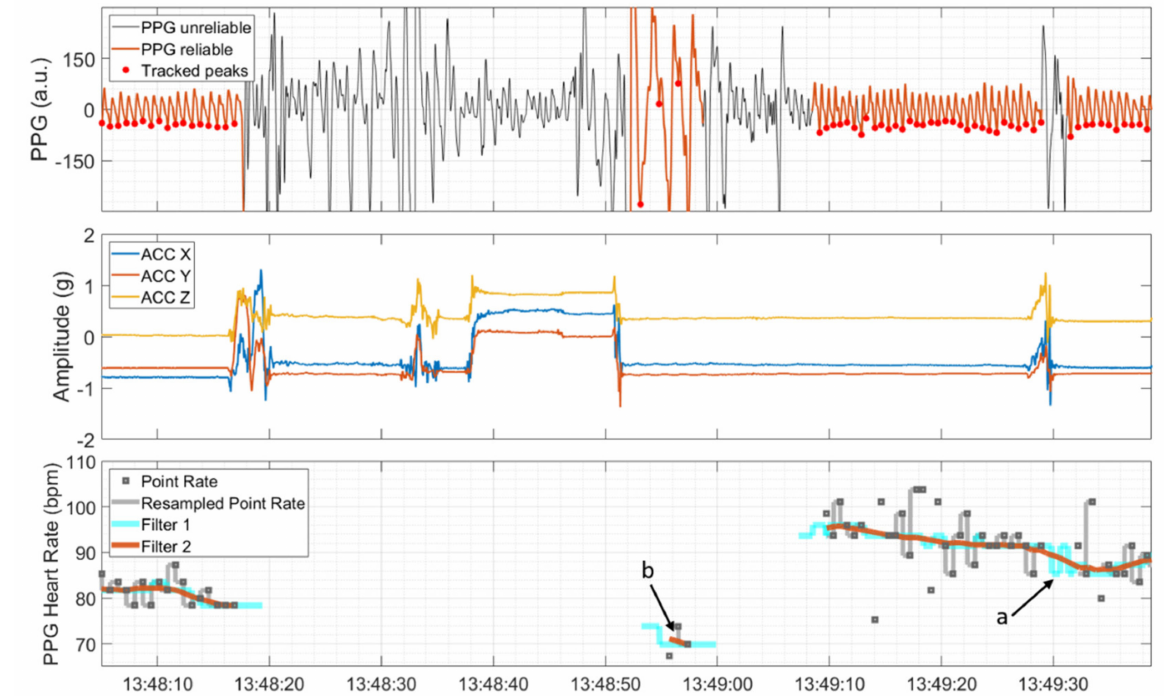
Figure 3. PPG signal, automatically divided into sections of reliable and unreliable quality and detected peaks (upper panel), and ACC signal showing movements at the same time (middle panel). The PPG heart rate and the associated intermediate steps; that is, resampling of the point rate, moving median (Filter 1), and moving mean (Filter 2), are depicted in the lower panel. Short duration gaps are interpolated by Filter 1 (marked by ‘a’), and isolated short PPG HR segments are removed by a postprocessing step (marked by